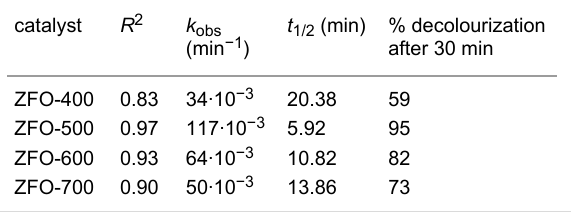
solution under solar irradiation for 30 min. The decolourization